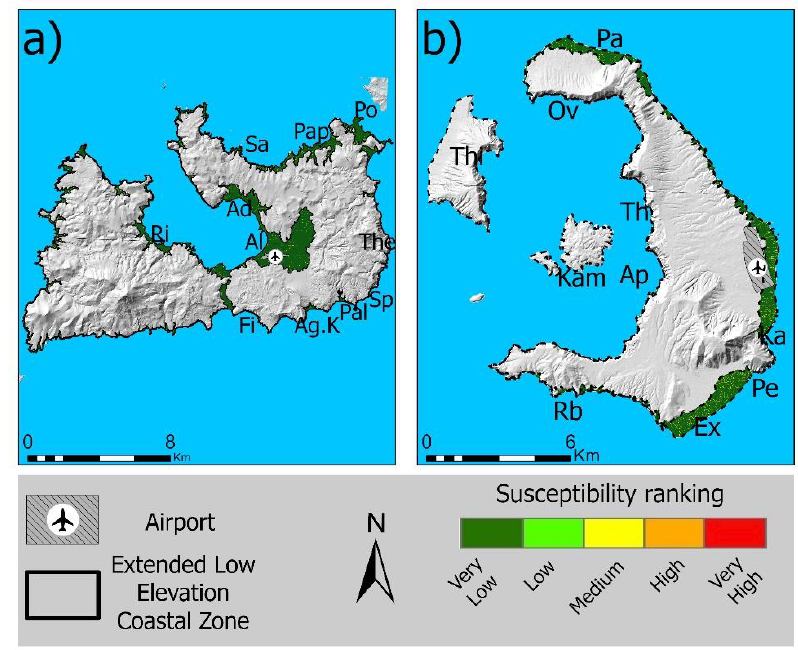
Table 9. Percentages of susceptibility classes to tsunami run-up scenario in Milos and Thira islands. Very Low Low Figure 10. Erosion susceptibility maps in Milos ( a ) and Thira ( b ) islands. Figure 10. Erosion susceptibility maps in Milos ( a ) and Thira ( b ) islands.